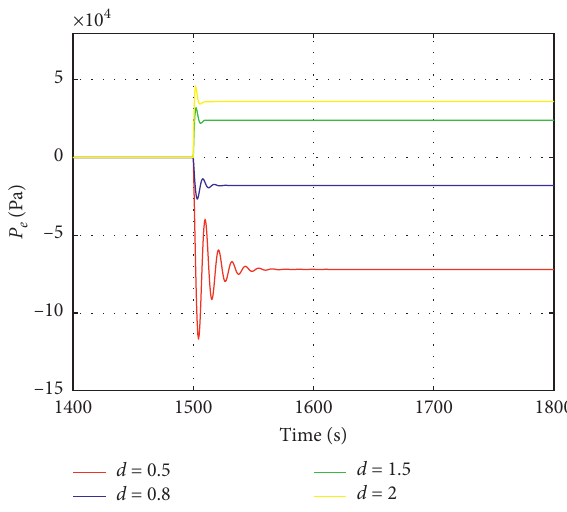
Figure 6: Pressure error caused by the constant gain drift of the pressure